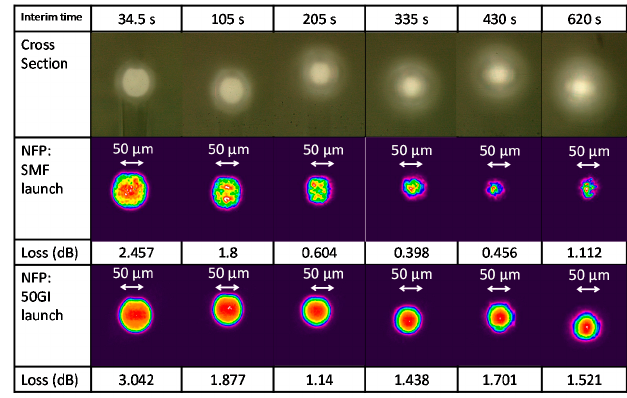
Figure 14. Interim time dependence of the cross-section, Near Field Pattern (NFP) and insertion loss of the polymer waveguide. the polymer